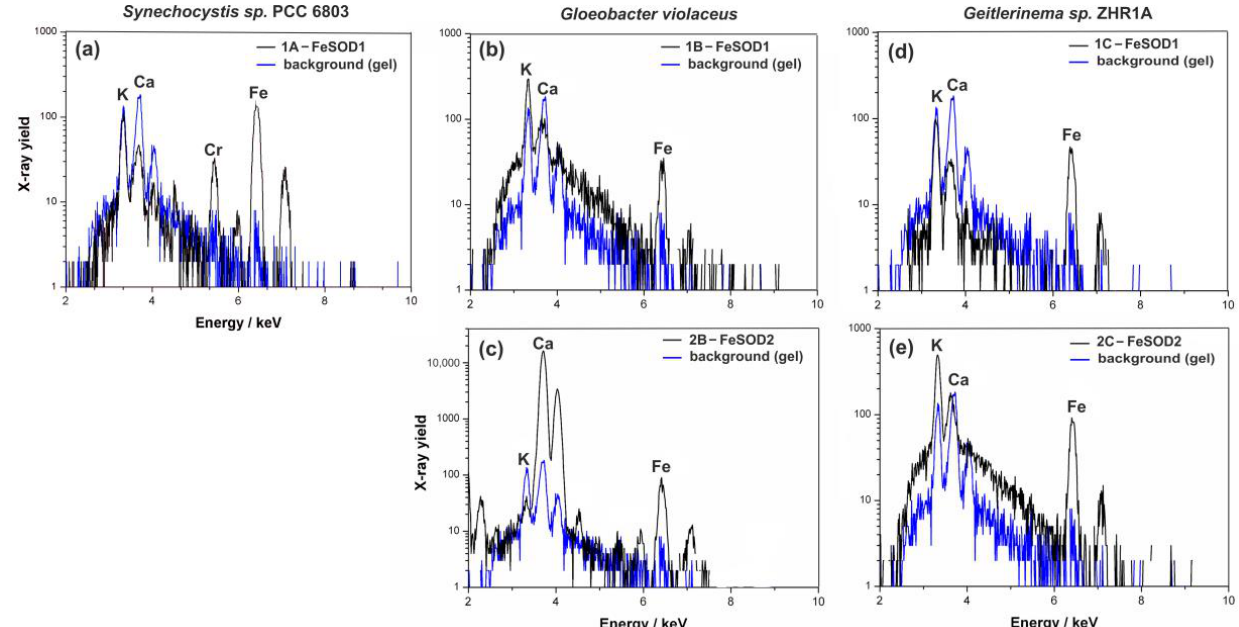
Figure 4. Particle-induced X-ray emission (PIXE) spectra with identified K α peaks of the bands of SOD, excised from the gel (see “Materials and Methods” and Figure 2). ( a ) Band 1A of Synechocystis sp. PCC 6803, ( b , c ) Bands 1B and 2B of Gloeobacter violaceus , and ( d , e ) Bands 1C and 2C of Geitlerinema sp. ZHR1A. These spectra are representative of three independent measurements.